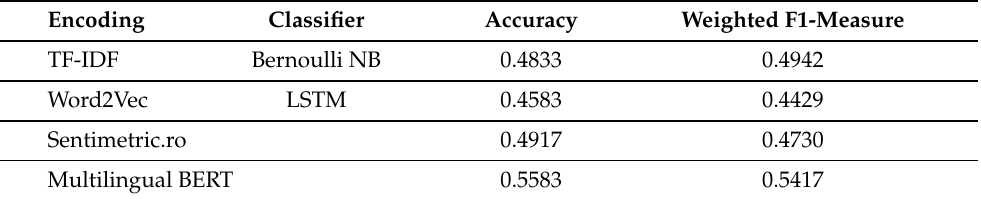
Table 5. Performance of various models (accuracy and weighted F1-measure) on a Romanian dataset with general